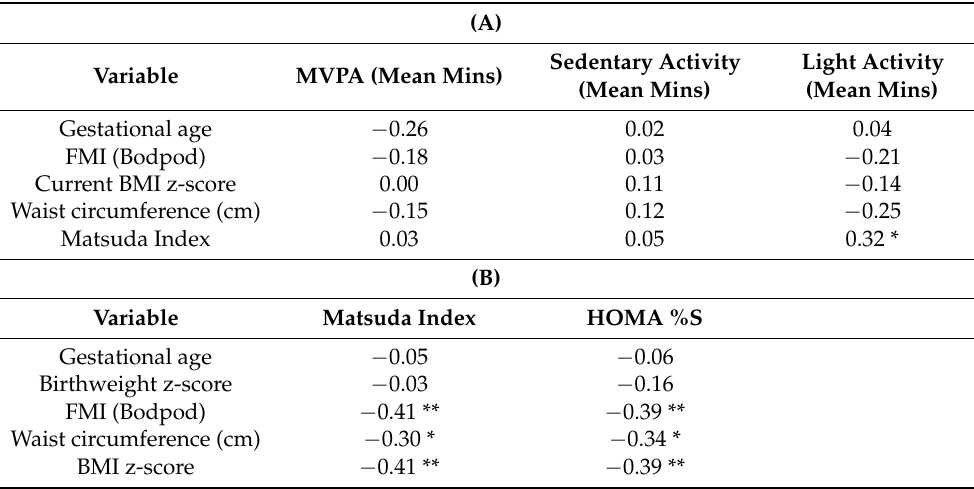
Table 3. Spearman’s correlation analysis for. ( A ) measures of physical activity, assessed by